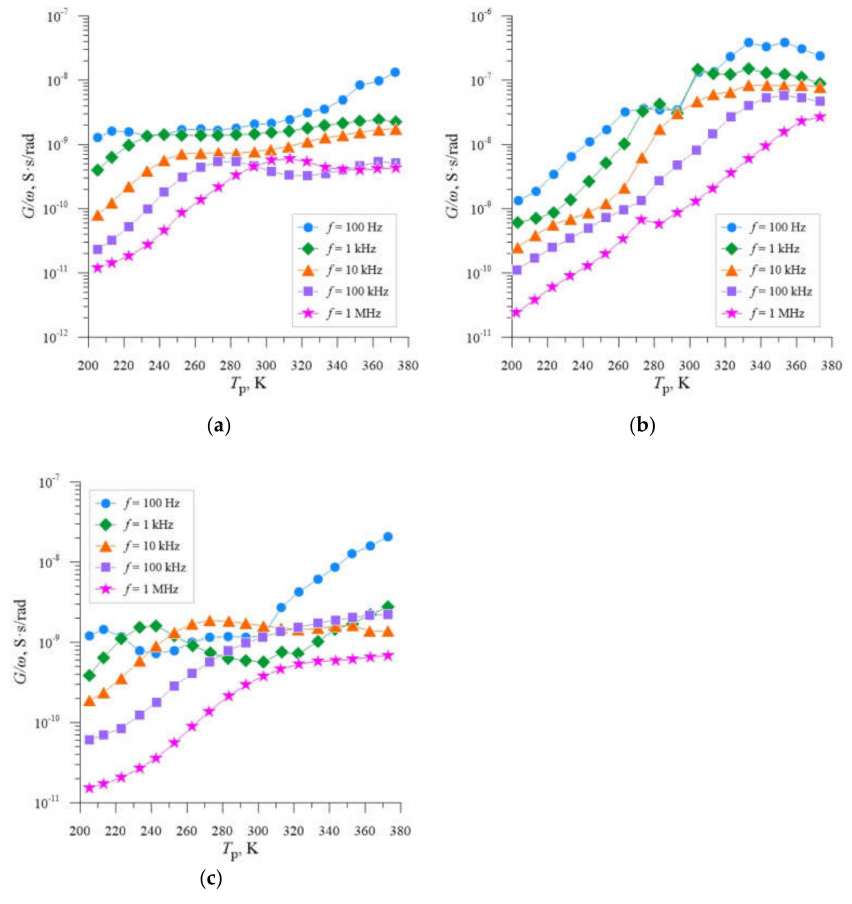
Figure 6. Dependencies G / ω = f( T p ) for silicon with resistivity ρ = 0.4 Ω cm, boron-doped, implanted with Ne + neon ions with energy E = 100 keV and doses of D = 4.0 × 10 13 cm − 2 ( a ), D = 2.2 × 10 14 cm − 2 ( b ), D = 4.0 × 10 14 cm − 2 , respectively, ( c ) determined for different f and the annealing temperature T a = 598